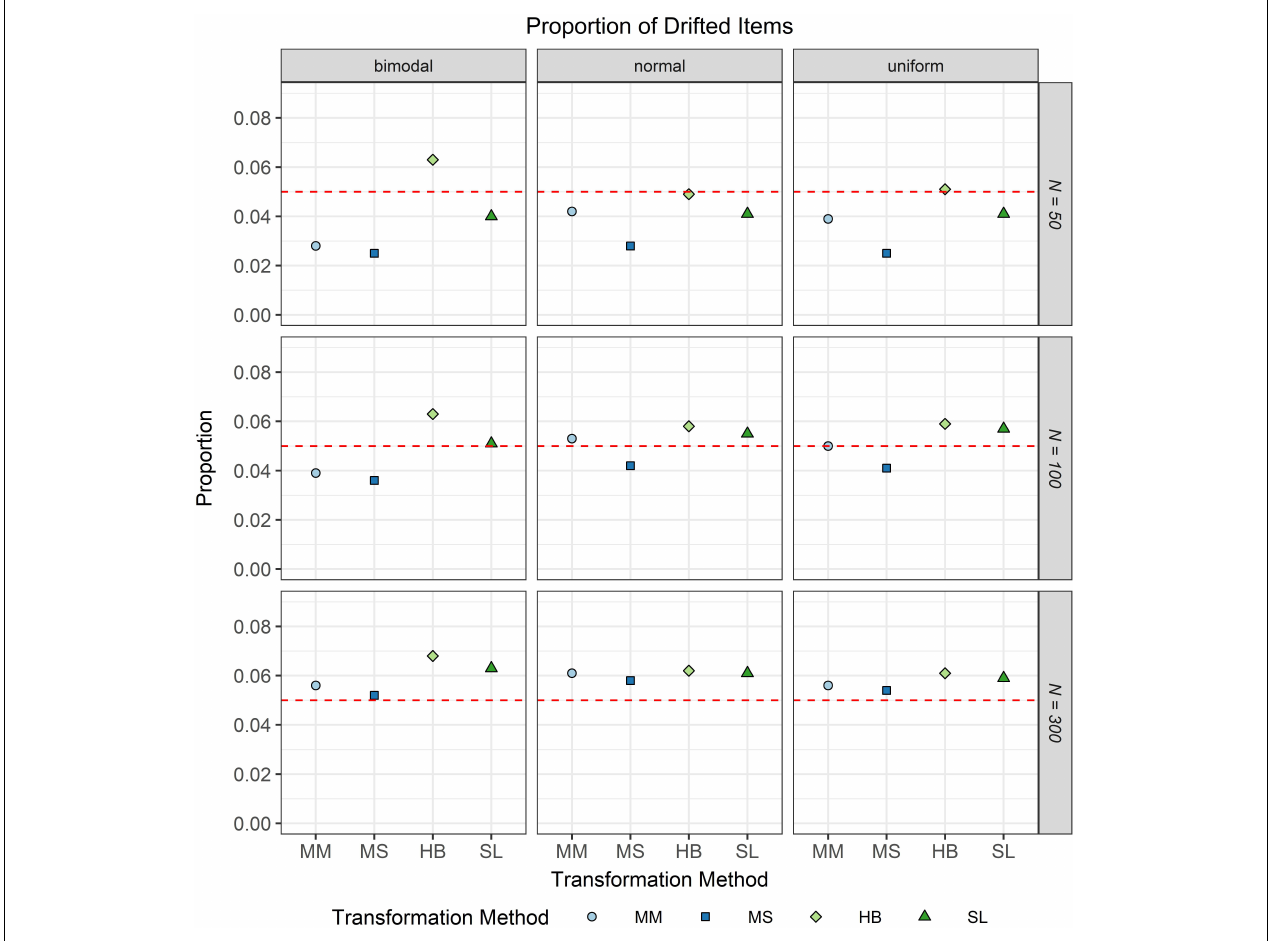
FIGURE 7 | Proportion of drifted items in the continuous calibration strategy for different sample sizes per test cycle, different common item difficulty distributions, and different scale transformation methods (MM = Mean/Mean, MS = Mean/Sigma, HB = Haebara, SL = Stocking-Lord). The dashed line represents the type I error level of